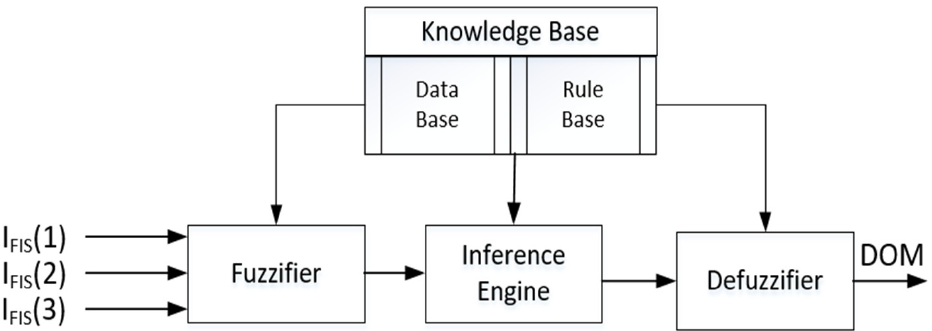
Figure 2. Block diagram of the FIS proposed to combine the scores of the specified classifiers.